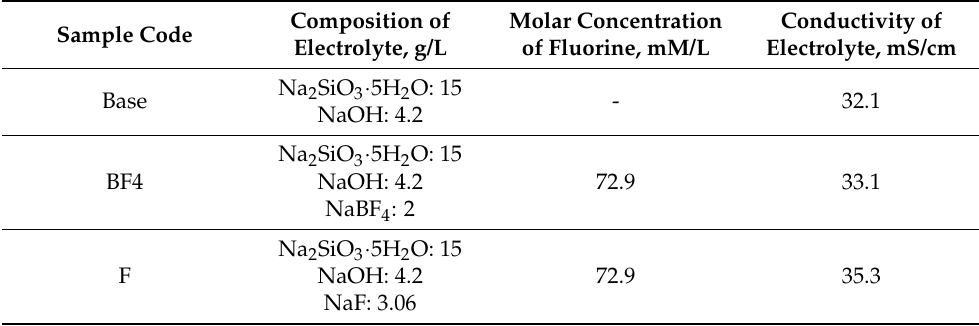
Table 2. The identification codes for the PEO coatings with their respective electrolyte composition and conductivity.